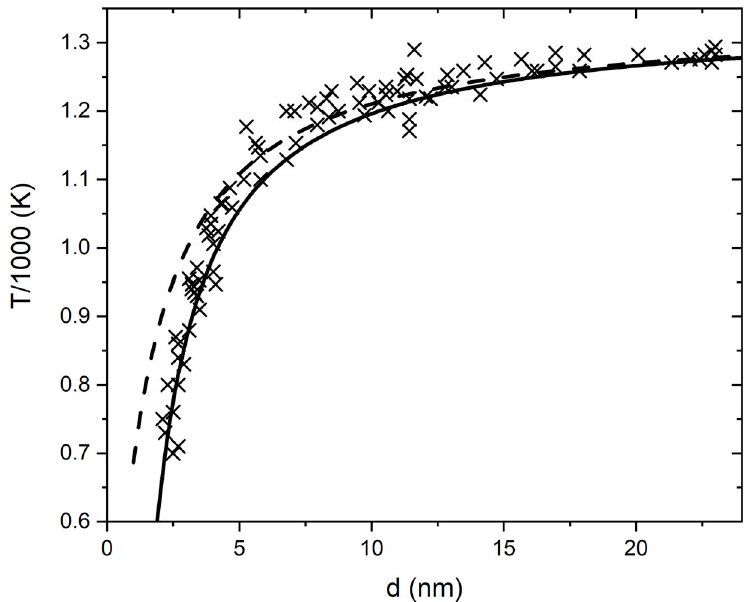
Figure 2. Experimental data [16] (x) and calculated melting temperatures of different diameter d gold clusters. The solid line represents Equation (9) and the dashed line represents n = a · d/d 0 in Equation (9).